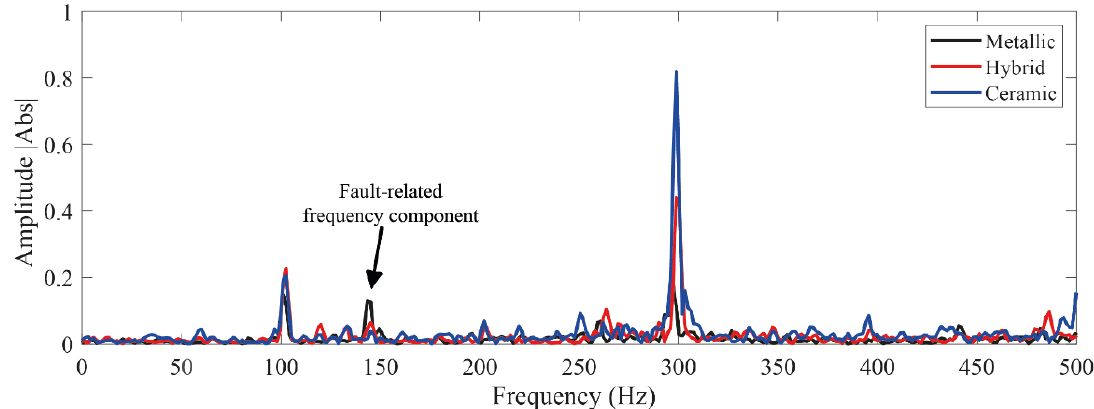
Figure 7. Frequency spectra obtained by applying the fast Fourier transform to the raw vibration signals of all considered bearing technologies: metallic, hybrid and full ceramic.